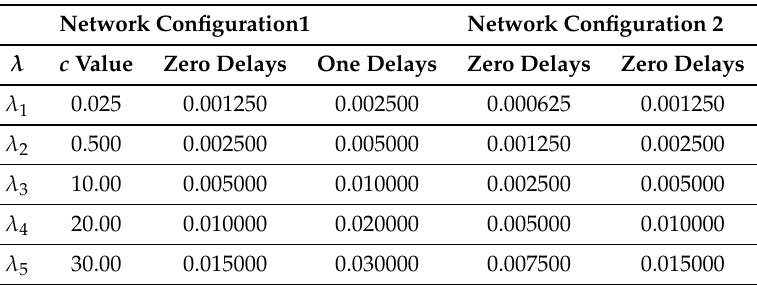
Table 3. Binary covert packet delays.